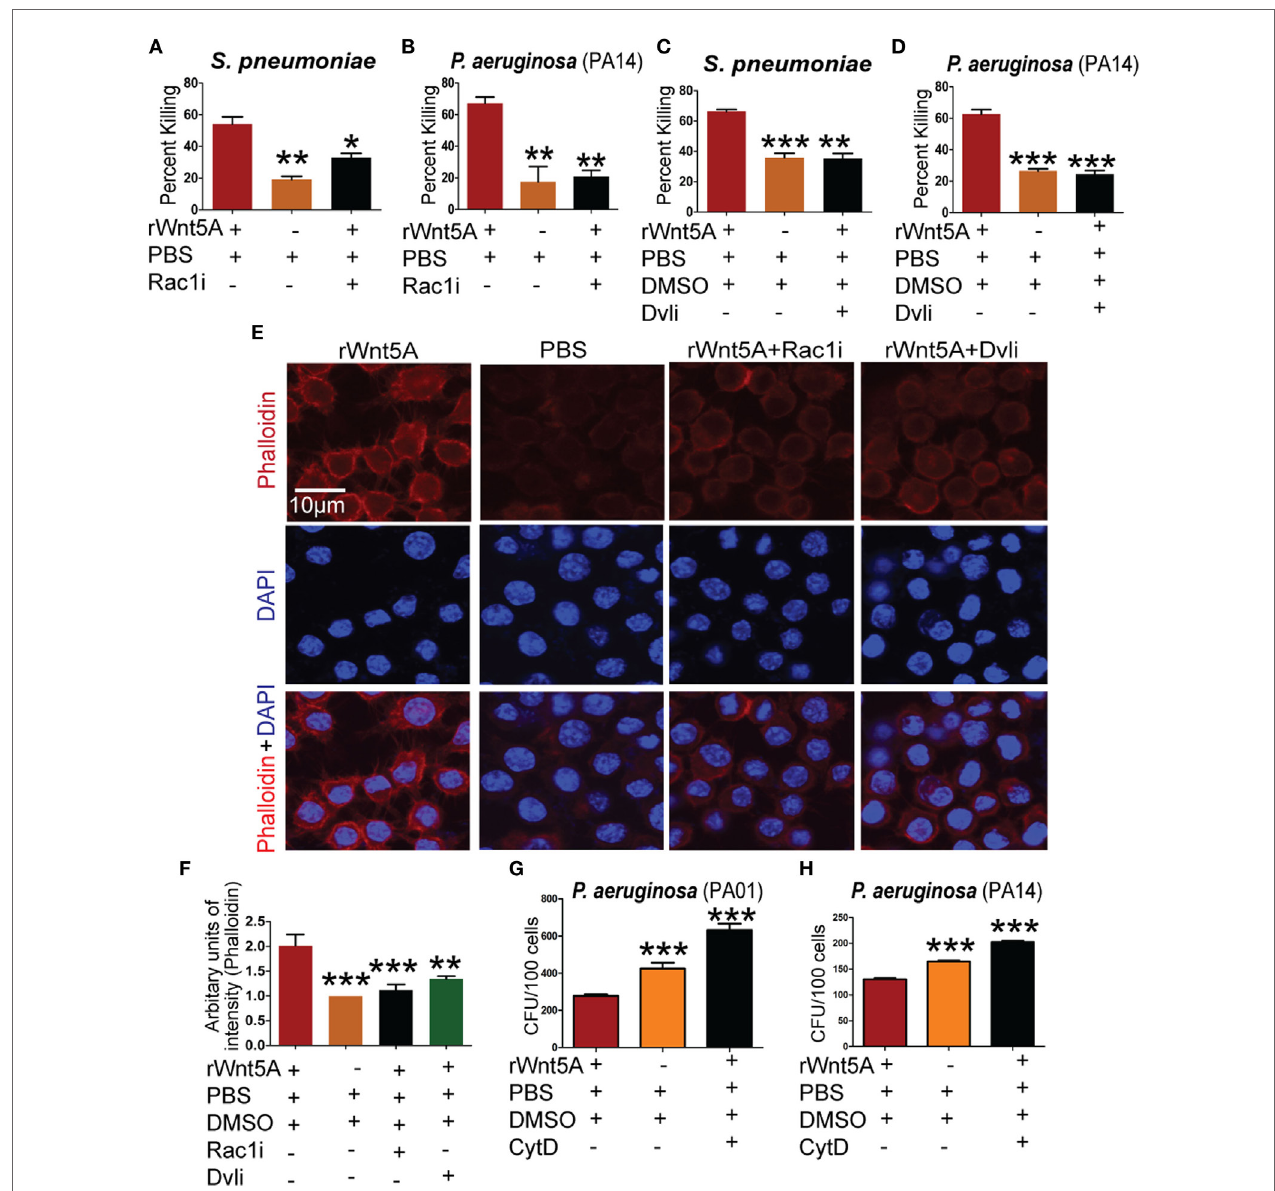
FigUre 4 | Wnt5A-mediated bacterial killing is Rac1–Dvl dependent and involves actin assembly. rWnt5A-induced clearance of bacteria [ Streptococcus pneumoniae (SP) and Pseudomonas aeruginosa (PA)] was inhibited by Rac1 inhibitor (Rac1i) (a,B) and Dvl inhibitor (Dvli) (c,D) at 3 h (T3) postinfection ( n = 3). PBS and DMSO act as vehicle control. (e) Inhibitory effect of Rac1i and Dvli on Wnt5A-induced actin polymerization as detected by phalloidin staining. (F) Difference in phalloidin fluorescence intensities calculated by NIH-ImageJ software ( n = 3). (g,h) Inhibitory effect of cytochalasin D (CytD) (postinfection) on Wnt5A-mediated bacterial killing. Data represented as mean ± SEM; * p ≤ 0.05, ** p ≤ 0.005, *** p ≤